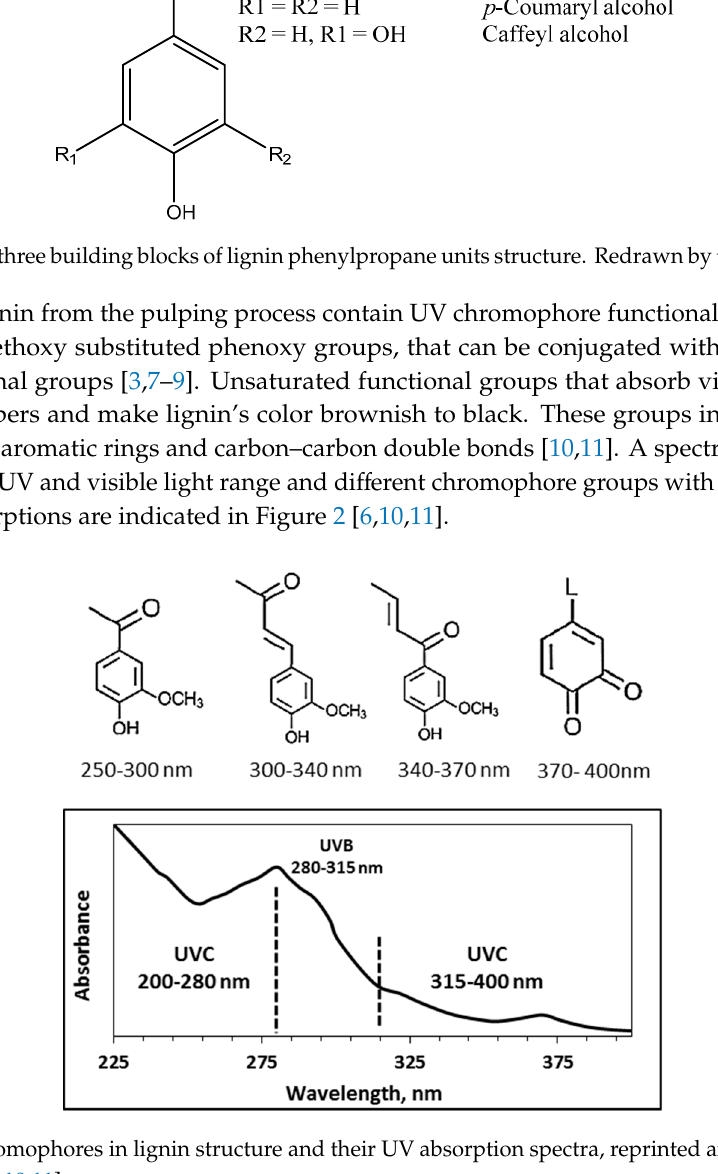
Figure 1. The three building blocks of lignin phenylpropane units structure. Redrawn by the authors [2].